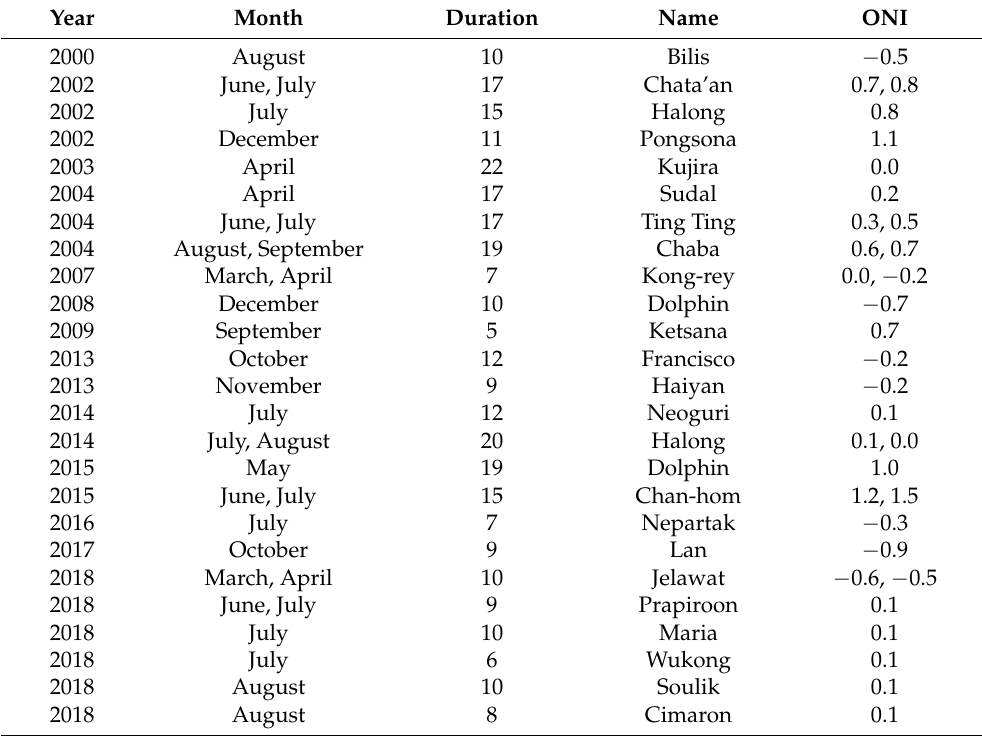
Table 1. Information about the twenty-five typhoons, including the duration, locations affected, and Oceanic Niño Index (ONI) value for each